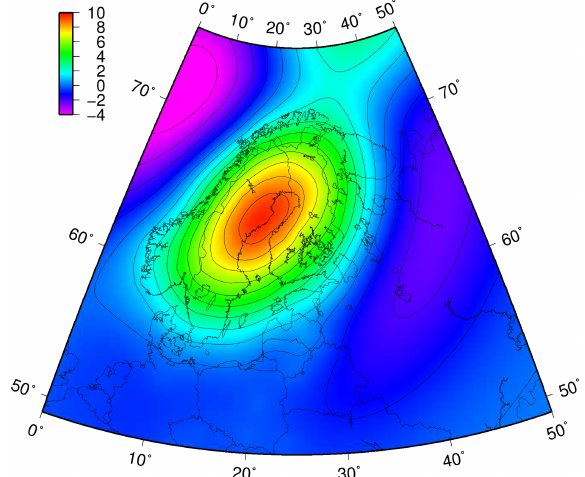
Fennoscandia relative to geoid given by the semi-empirical land up- lift model